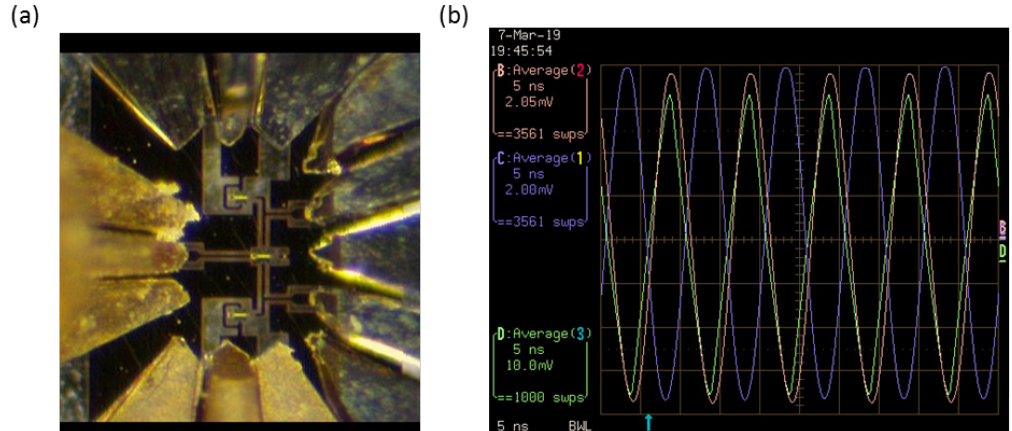
Figure 3. ( a ) Photography of the balun under measurement condition. ( b ) Oscilloscope measurement when applying a sinusoidal input voltage with an amplitude of 32 mV at the input (channel D) and sensing the two outputs (channel B and C).